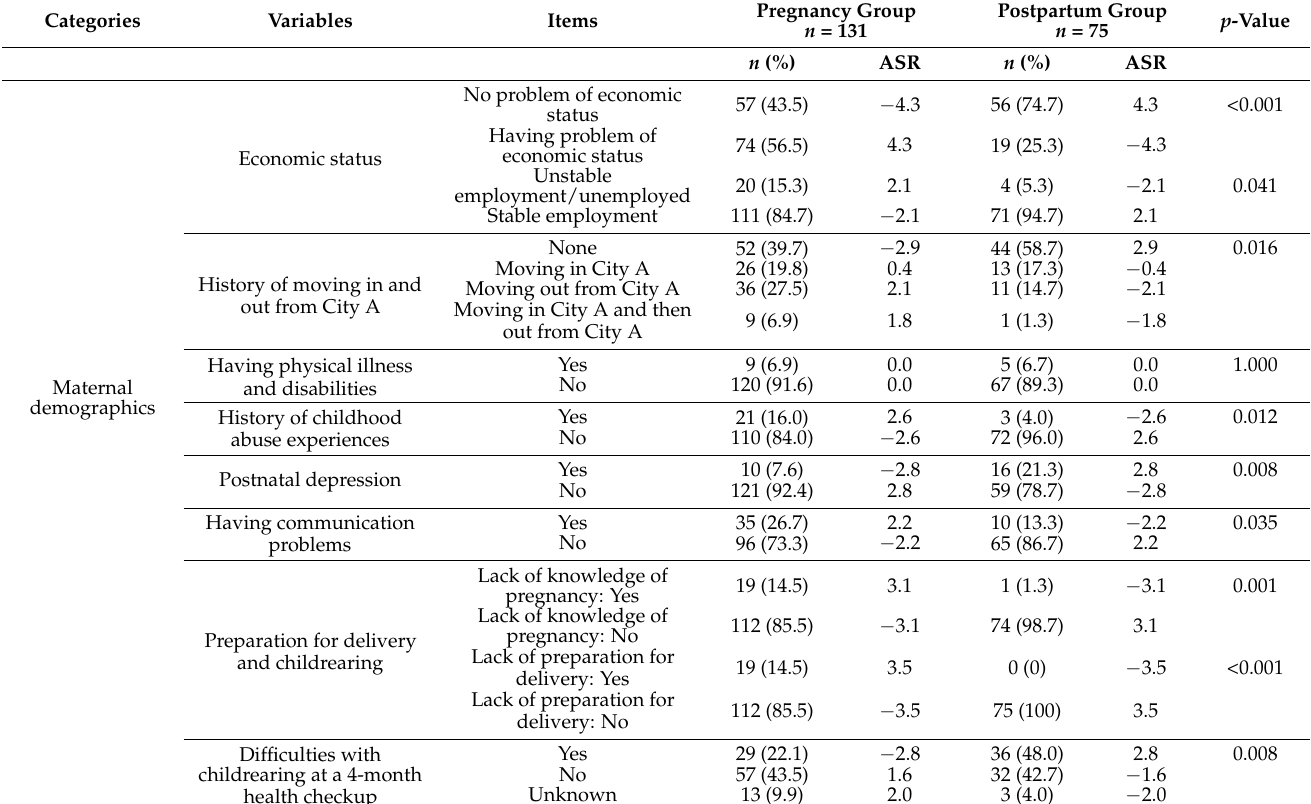
Table 1. Maternal demographics and Family-related factors of the pregnancy group and the postpartum group ( N = 206).